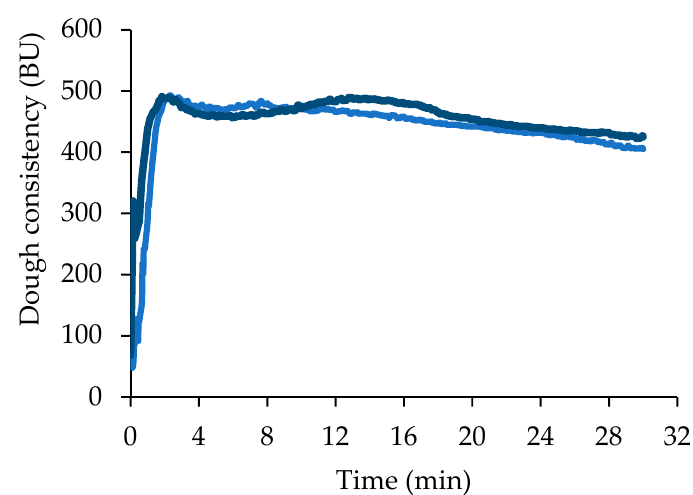
Figure 1. Mixing properties of flour without (light blue) and with (blue) sucrose addition (average values of two replicates, relative standard deviation values ≤ 10%). BU, Brabender Unit.